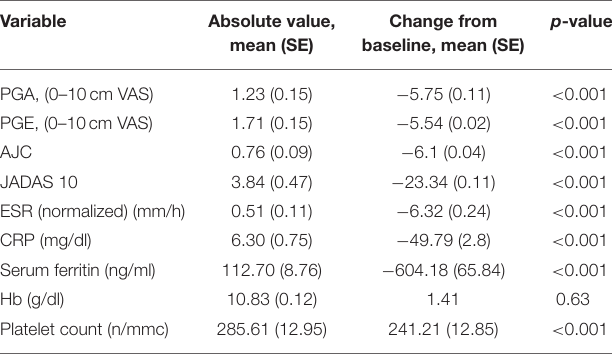
TABLE 4 | Secondary outcomes absolute values and change from baseline after 1 year of tocilizumab therapy.